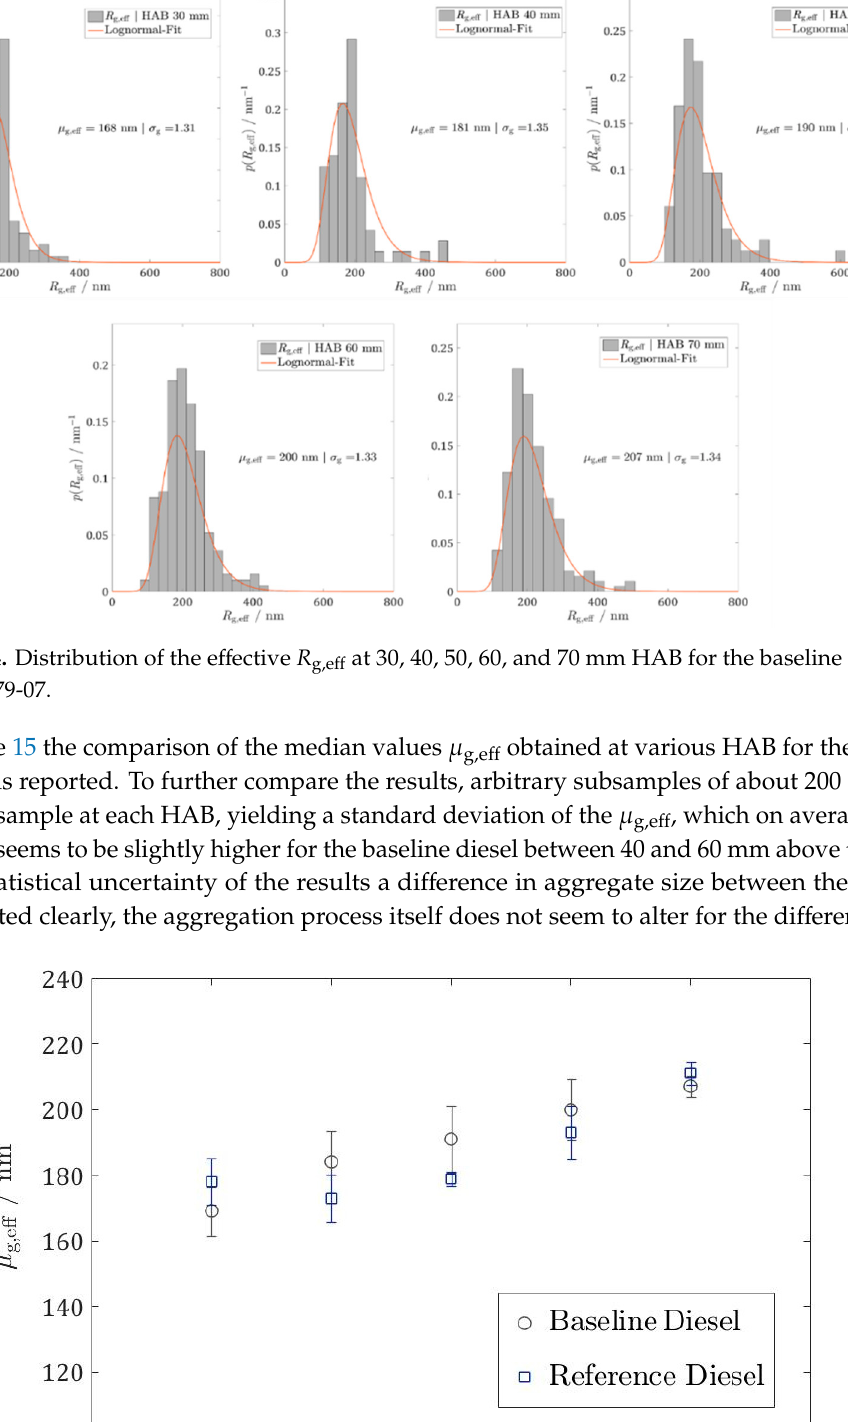
Figure 13. Distribution of the effective R g,eff at 30, 40, 50, 60, and 70 mm HAB for the reference diesel CEC RF-06-03.